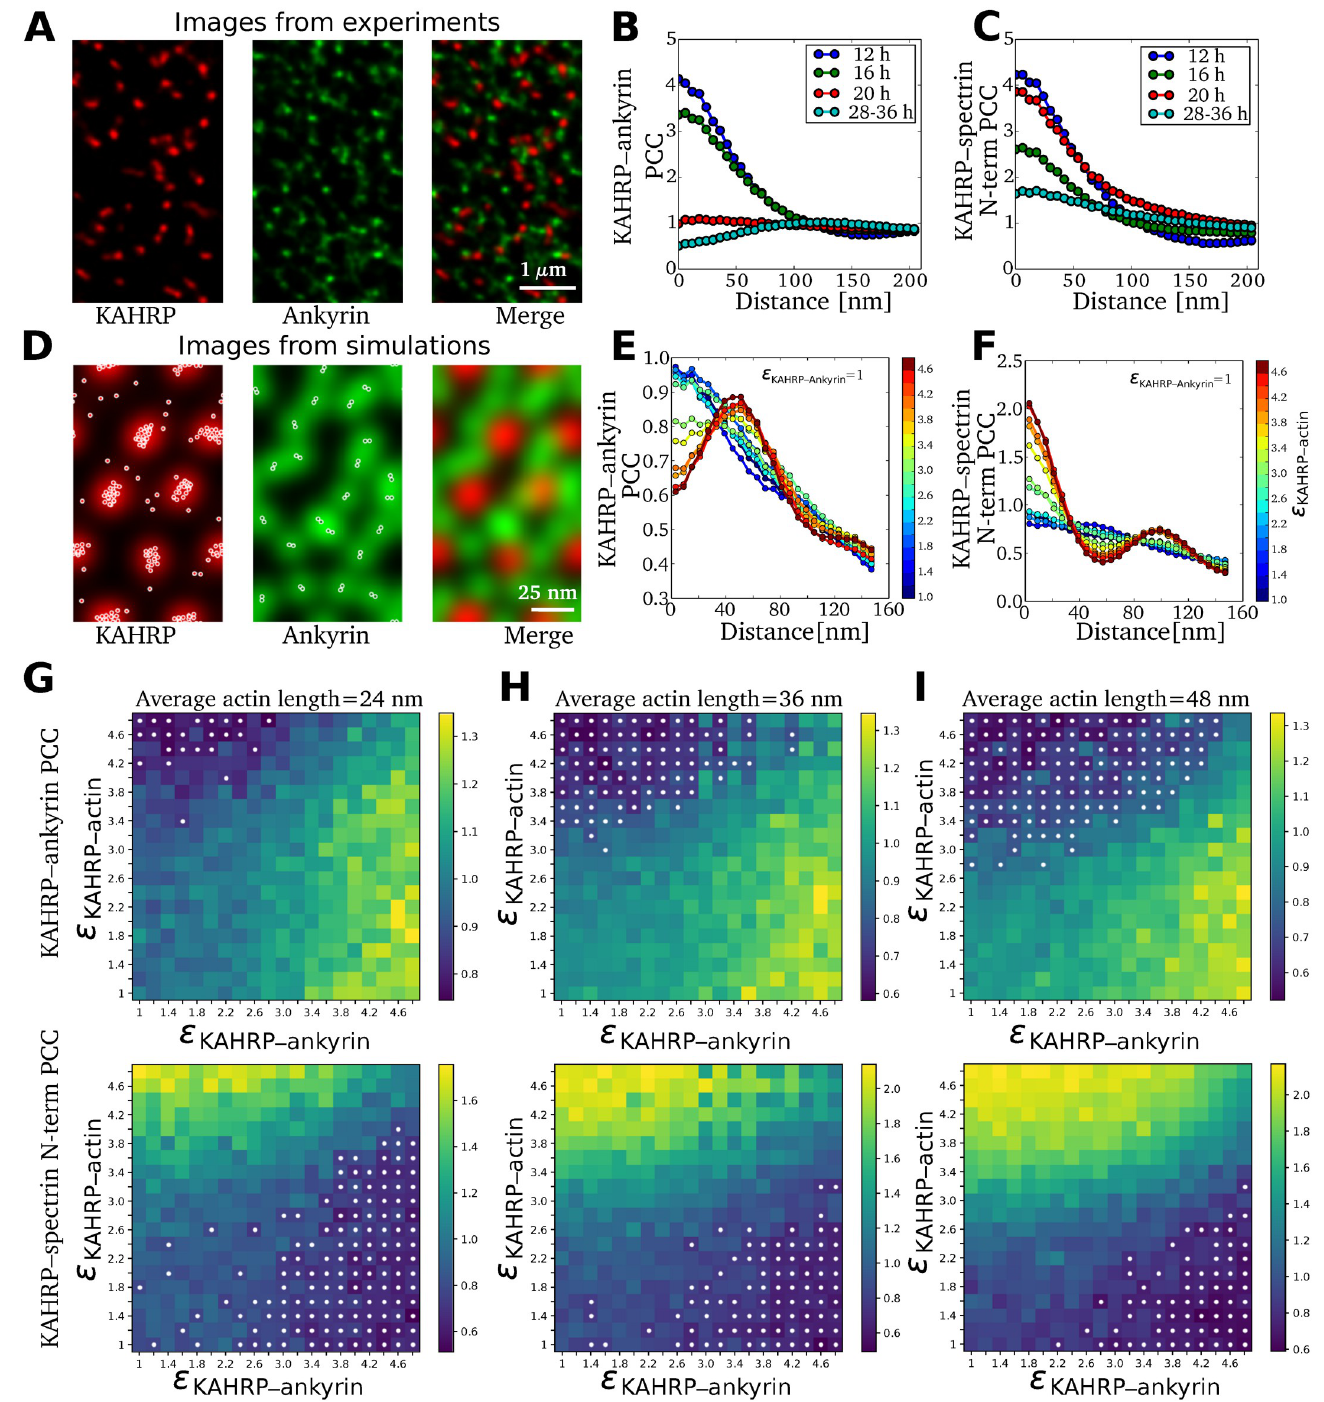
Fig 7. Comparison of experimental and simulated pair cross-correlations. (A) STED images of an exposed RBC membrane at the trophozoite stage (28–36 hours post malaria infection). Red and green fluorescence signals correspond to KAHRP and ankyrin sites on the RBC membrane. (B) Pair cross-correlation (PCC) between KAHRP and ankyrin computed using the two-color images obtained at different hours post malaria infection. (C) PCC between KAHRP and N- terminus of β -spectrin. Images and PCC values in (A,B) are taken from [35]. (D) KAHRP (red) and ankyrin (green) fluorescence signal is constructed from location points obtained from simulations (overlaid white points). (E) PCC between KAHRP and ankyrin is computed from two-color images generated from simulations for different binding energy between KAHRP and actin as indicated by the color bar. (F) Same as (E) for the KAHRP and N-terminus of spectrin PCC. (G) The map shows PCC values at zero distance for KAHRP-actin pairs (top panel) and KAHRP-ankyrin pairs (bottom panel) at different binding rates between